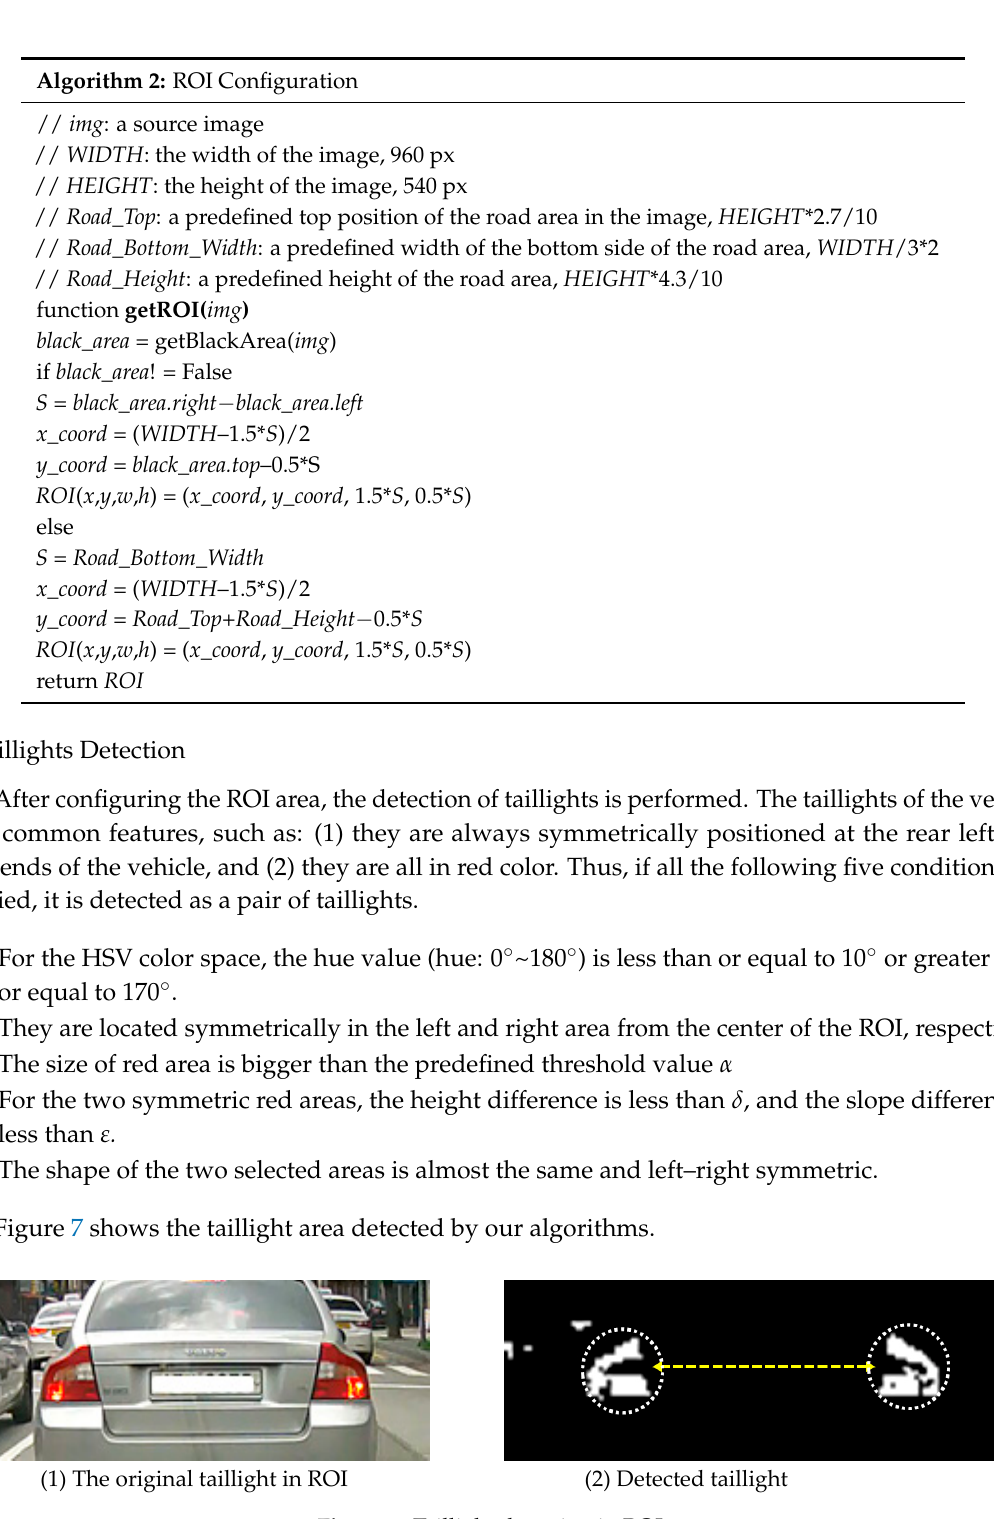
Figure 7. Taillight detection in ROI.